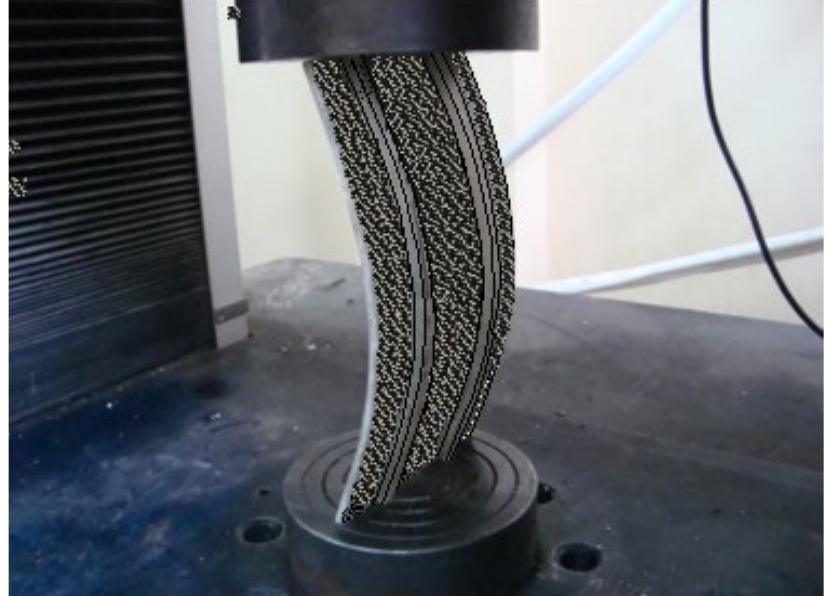
Figure 6. Rectangular plate with two stiffeners.